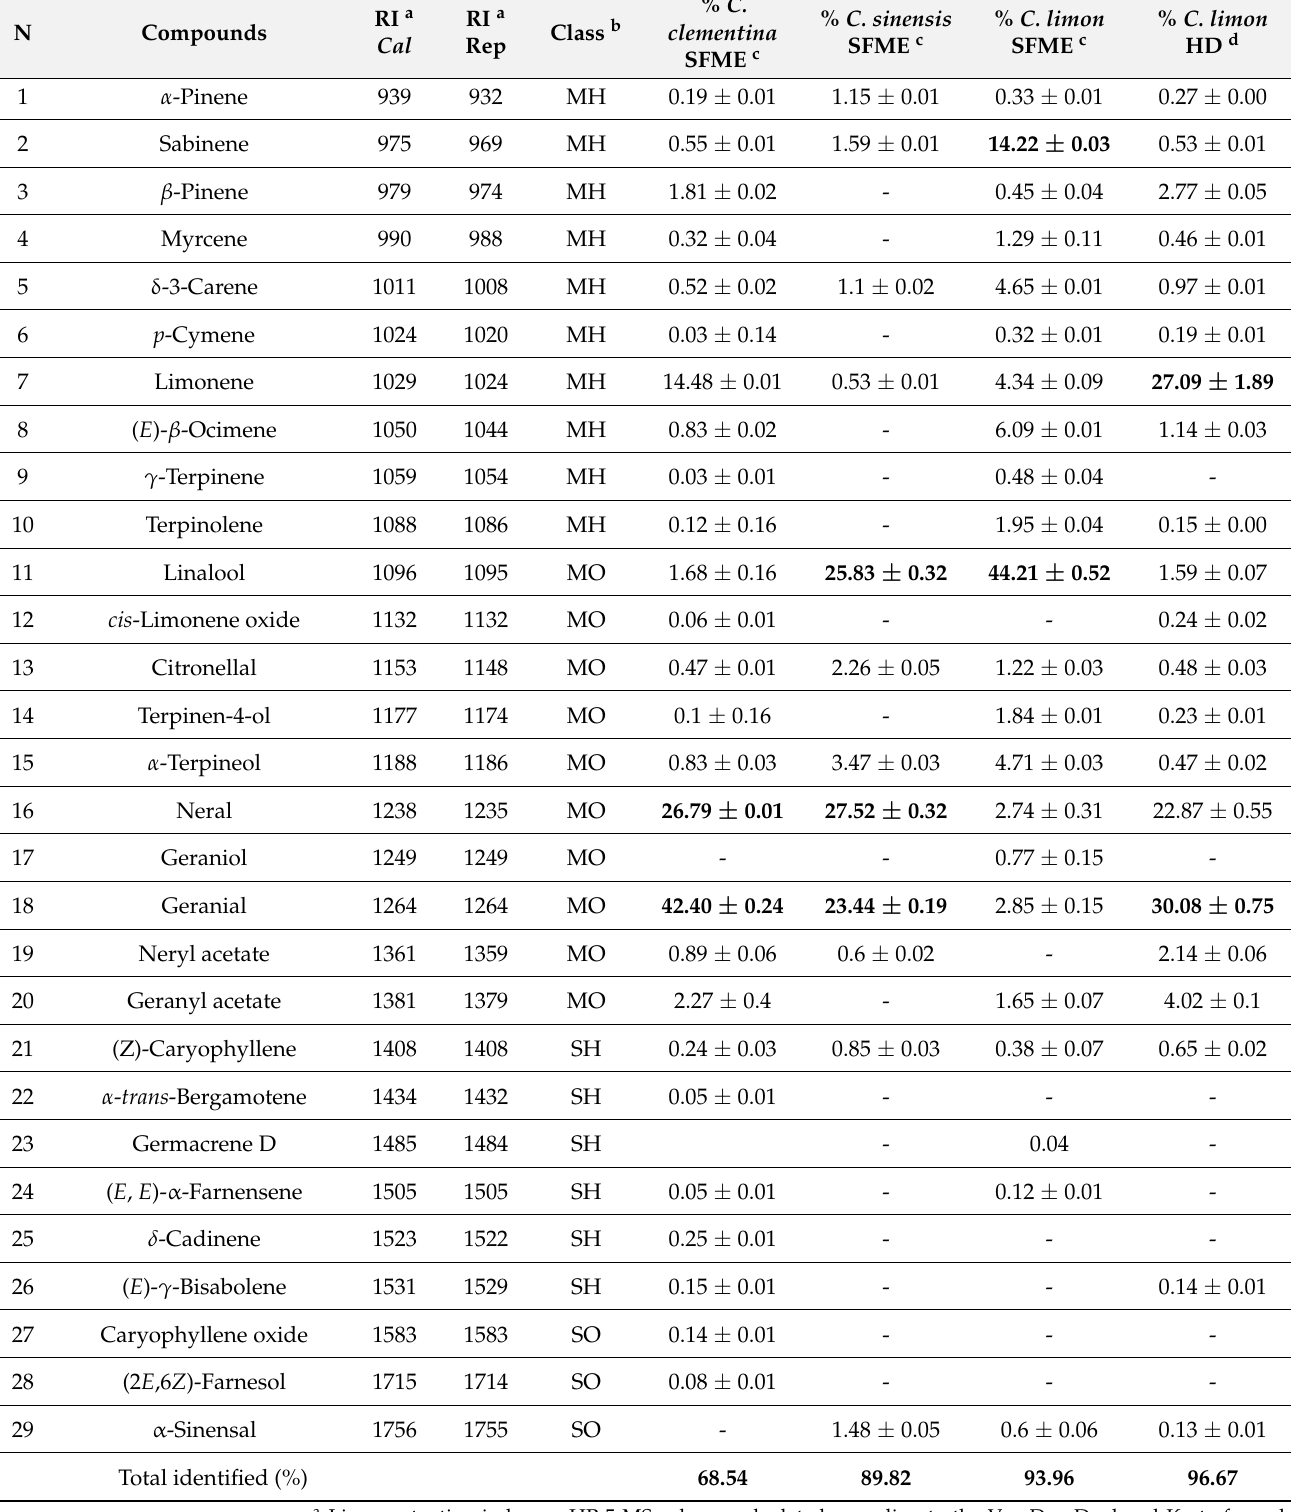
Table 1. Chemical composition (%) of the essential oils isolated from Citrus species leaves using GC/MS